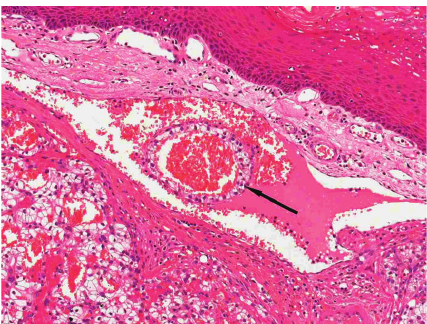
Figure 4: The tumour comprises polygonal cells with clear cyto- plasm arranged as alveoli, separated by thin fibrous septa, around a richly vascular stroma. The presence of a “ring” of neoplastic clear cells (arrow) within a dilated capillary indicates intravascular invasion. Haematoxylin and eosin, original magnification ×